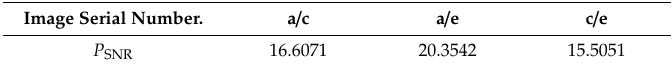
Table 1. The first set of data gray images mutual P SNR values.